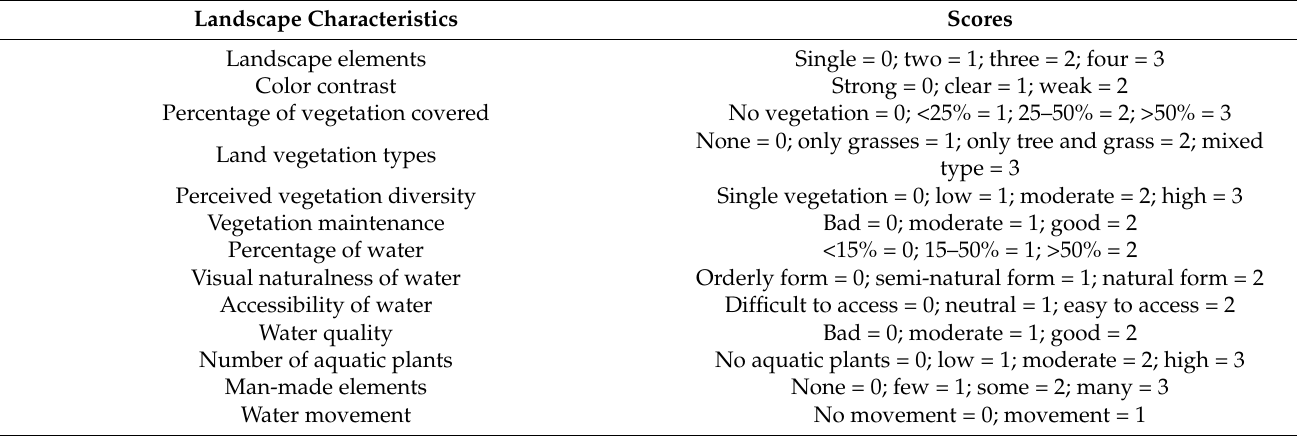
Table 3. The scale of landscape characteristics to